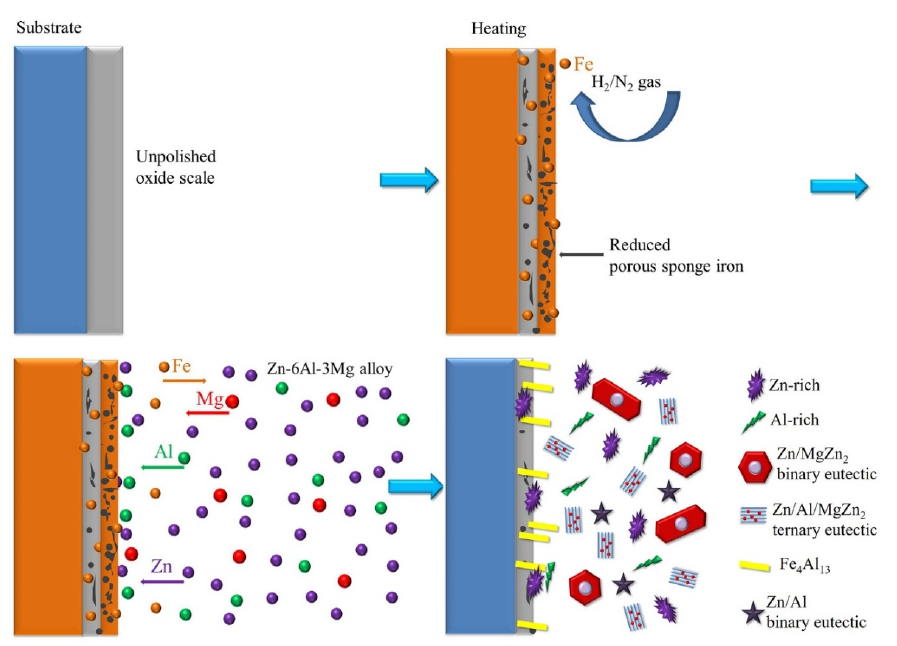
Figure 15. Element distribution of the cross section of the coating of an unpolished steel plate. ( a ) The cross-sectional morphology of the coating, ( b ) All elements, ( c ) Al, ( d ) Fe, ( e ) O, ( f ) Mg, ( g ) Zn.